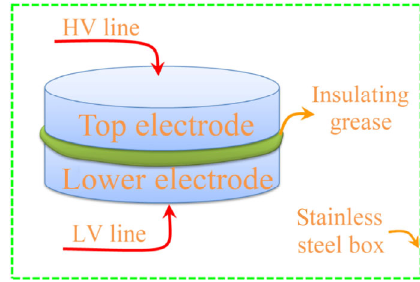
Fig. 2 Diagram of plate electrode structure.